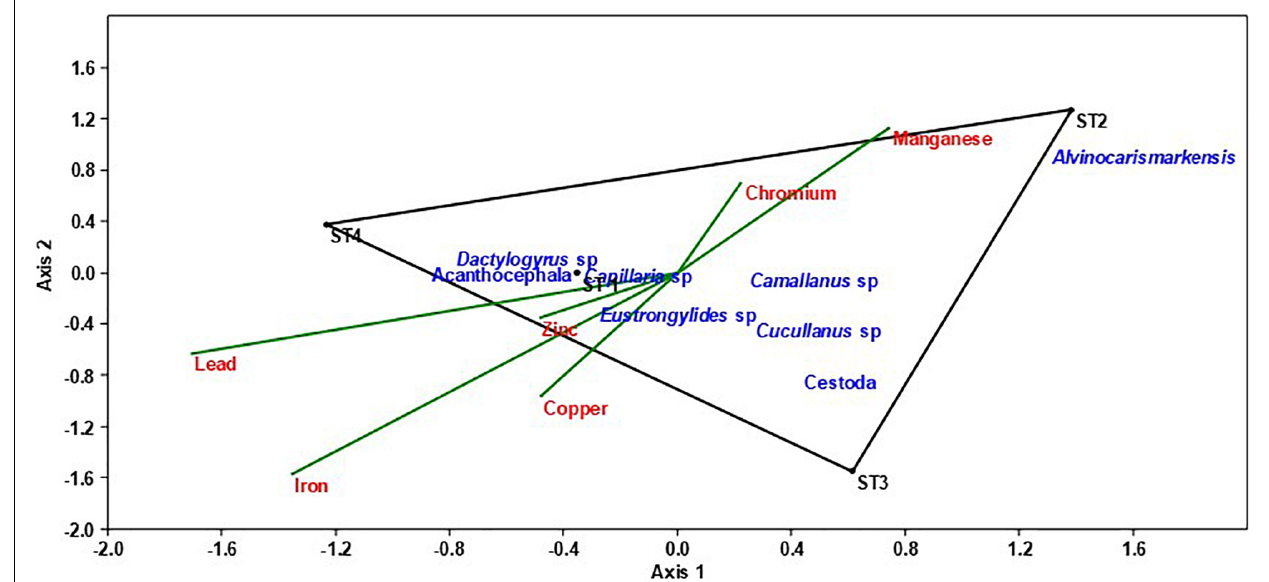
FIGURE 2 | Canonical Correspondence Analysis (CCA) ordination plots of Pb, Cu, Mn, Zn, Fe, and Cr association with helminths parasites metrics of the fish samples collected in Chanchaga River.